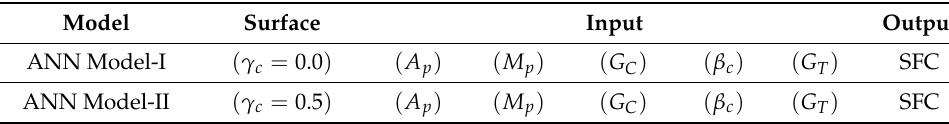
Table 1. Input and output details for ANN models.